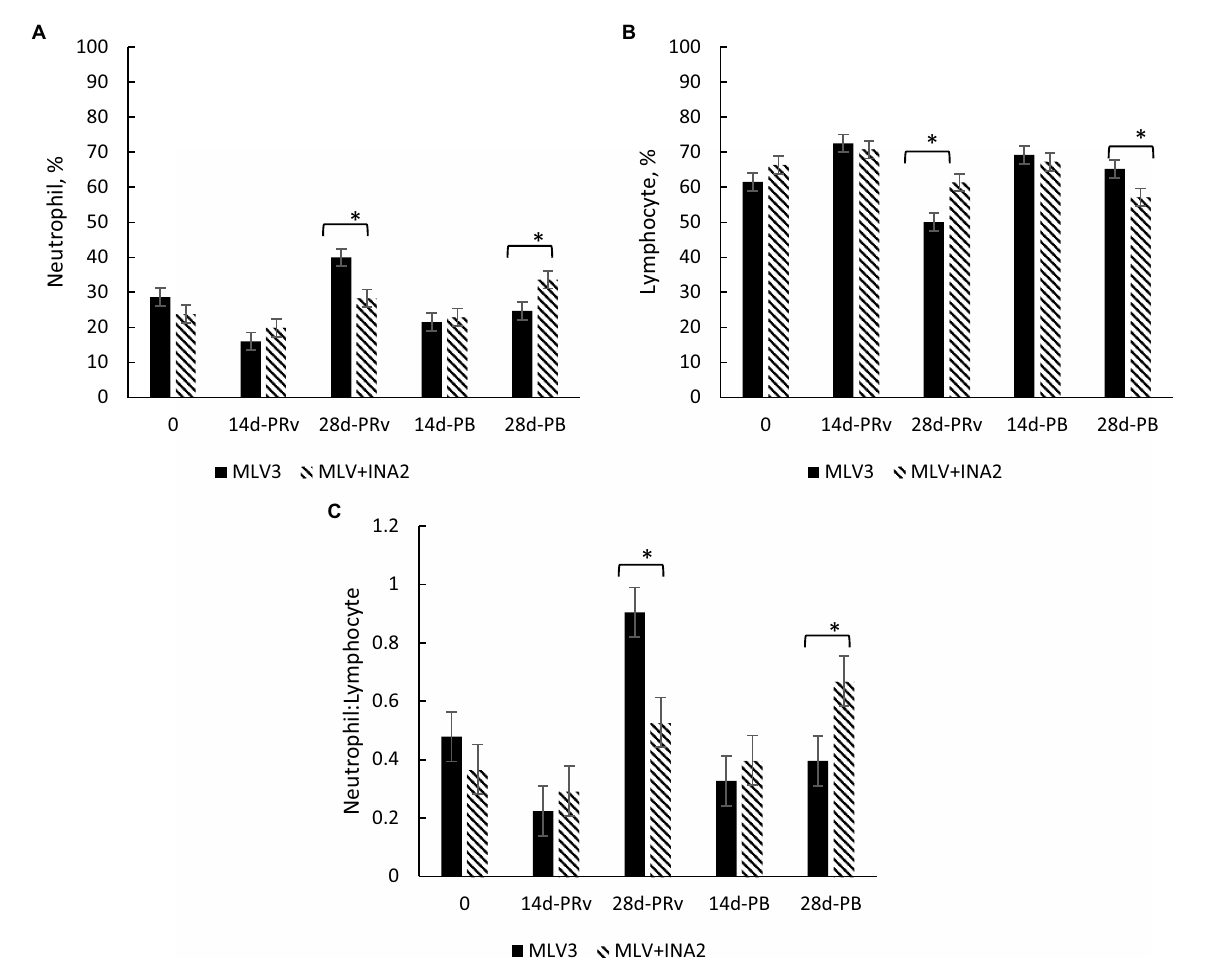
FIGURE 1 Effect of vaccine treatment on percentage of neutrophils (A) , percentage of lymphocytes (B) and the ratio of neutrophils to lymphocytes (C) at 14 and 28 days post-revaccination (PRv) and post-booster (PB), n = 28 heifers. Data are expressed as means ± standard error of the mean. Means with * between treatments within a day differ at p < 0.05. Treatment × Day = p = 0.001 for Neutrophil %, p = 0.003 for Lymphocyte %, p = 0.003 for Neutrophil to Lymphocyte